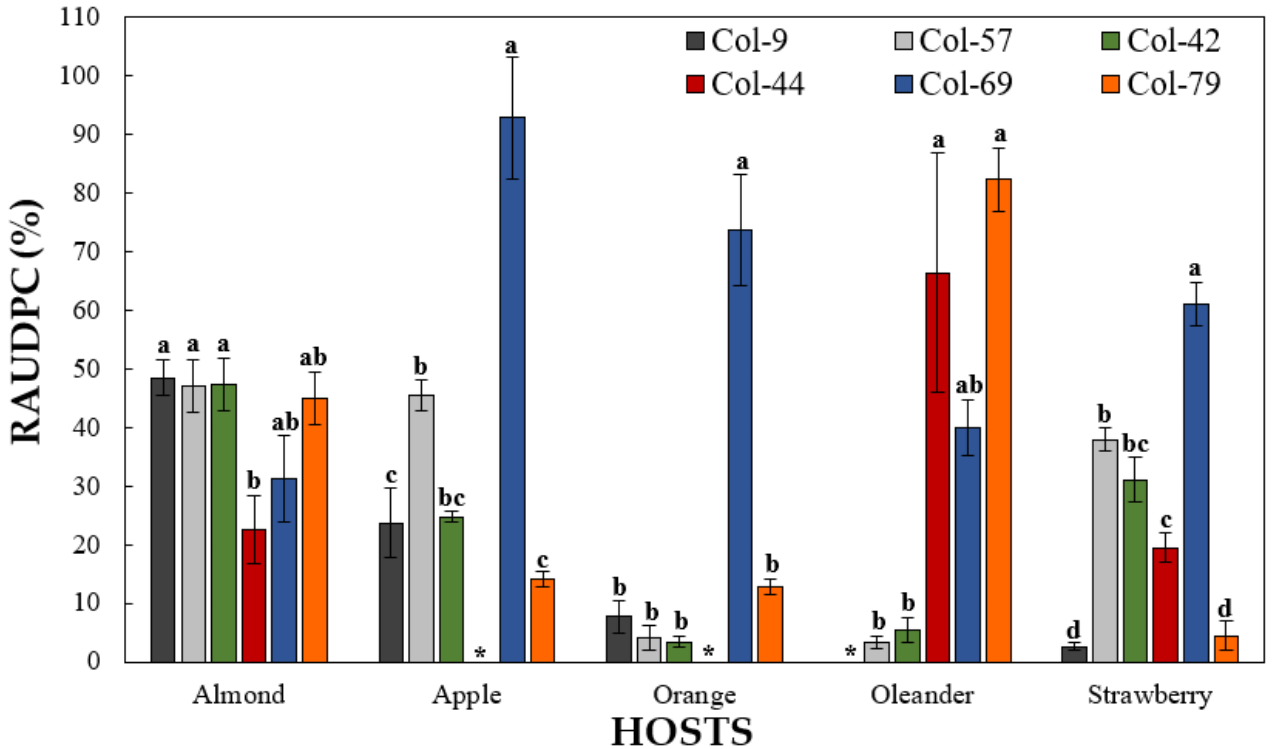
Figure 9. Relative area under the disease progression curve (RAUDPC) on fruits of almond cv. Guara, apple cv. Golden Delicious, sweet orange cv. Lane Late, strawberry cv. Camarosa, and on oleander leaves inoculated with the following isolates: Colletotrichum godetiae from olive (Col-9 and Col-57), C. gloeosporioides from sweet orange (Col-69), C. karstii from sweet oranges (Col-79), C. nymphaeae from olives (Col-42), and C. siamense from strawberries (Col-44). Columns are the means of two independent sets (experiments) of three replicated (humid chambers) in each host inoculation, with 10 fruit or leaves per host and per humid chamber. Vertical bars are the standard error of the means. For each host, columns with the same letter are not significantly different according to the Tukey’s HSD test at p = 0.05. * Isolates not pathogenic to these hosts.